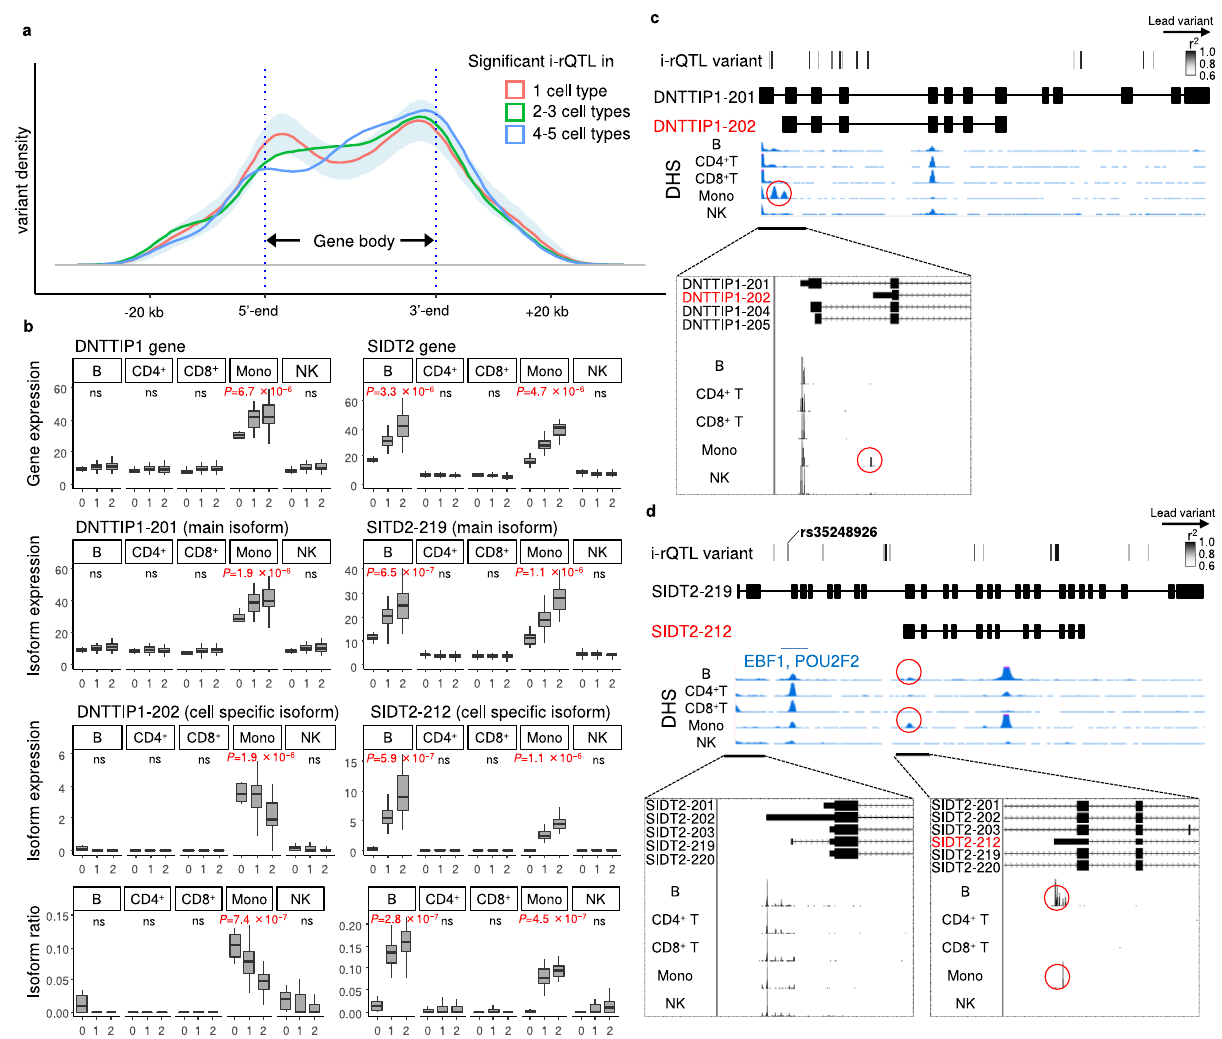
Fig. 2 | Cell-type speci fi c i-rQTL. a For each cell-type speci fi city, distributions of lead i-rQTL variants to the gene body are shown. The shade shows 95% con fi dence intervals for the mean of the distribution of 1 cell-type speci fi c i-rQTLs. b The DNTTIP1-202 isoformhad amonocyte-speci fi ci-rQTLeffect.The SIDT2-212 isoform hadB-cell-and monocyte-speci fi ci-rQTLeffects.These geneswereexpressedinall fi ve cell types. On the boxplots the horizontal line indicates the median, the box indicates the fi rst to third quartile of expression and whiskers indicate 1.5×the interquartile range. Nominal p -values obtained by two-tailed tests are shown for